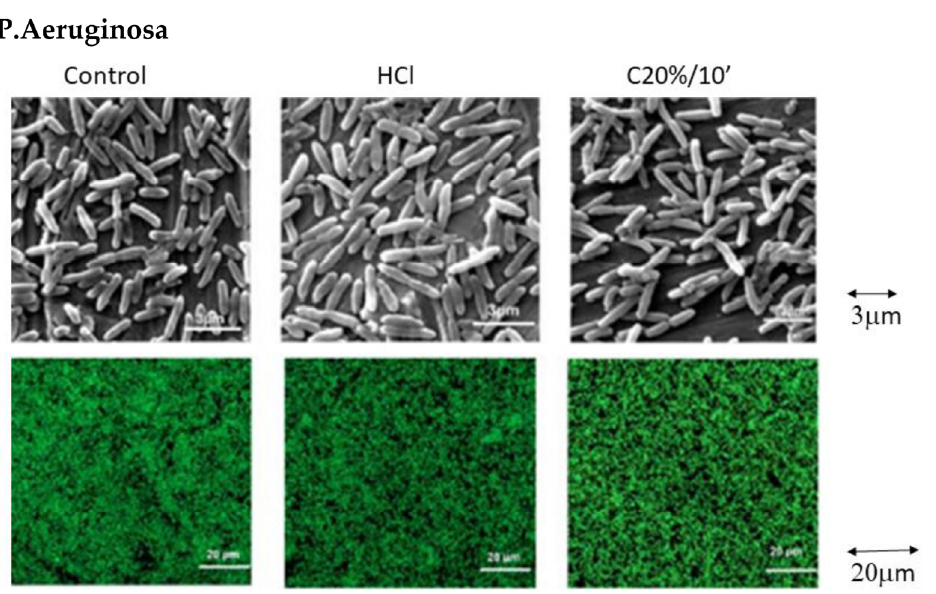
Figure 6. Analysis of P. aeruginosa ( a ) and S. sanguinis ( b ) adhesion for the different treatments.